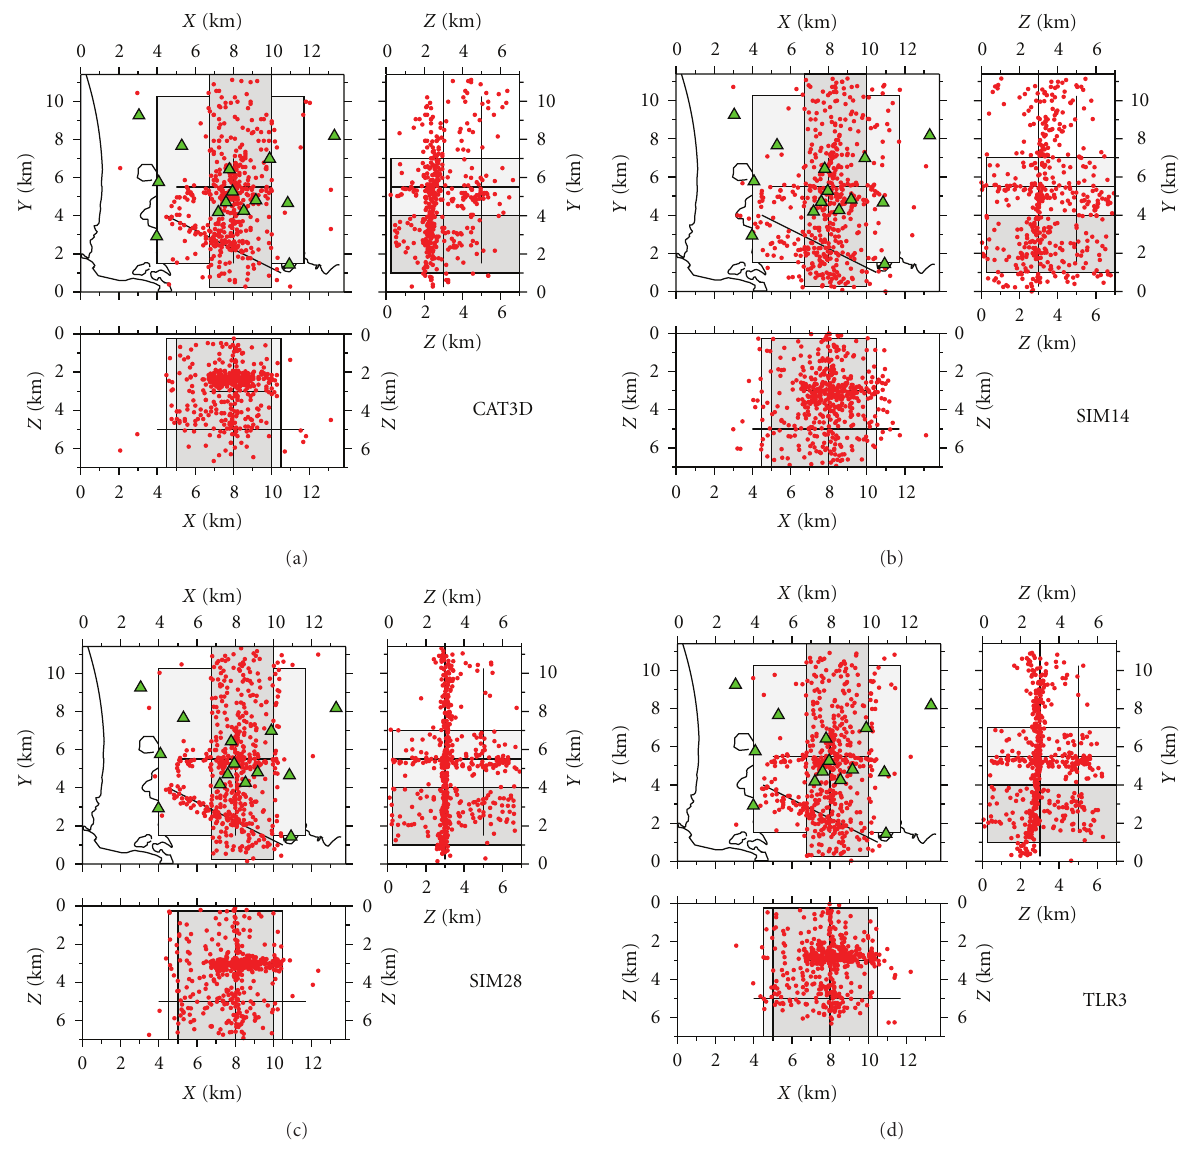
Figure 14: Hypocenters inverted by the di ff erent methods. (a) CAT3D + NNL, (b) SIM14, (c) SIM28, and (d) TLR3. Other details as in Figure 6. The grey shaded areas and black lines locate the virtual alignment planes of the true sources (see also Figure 6).